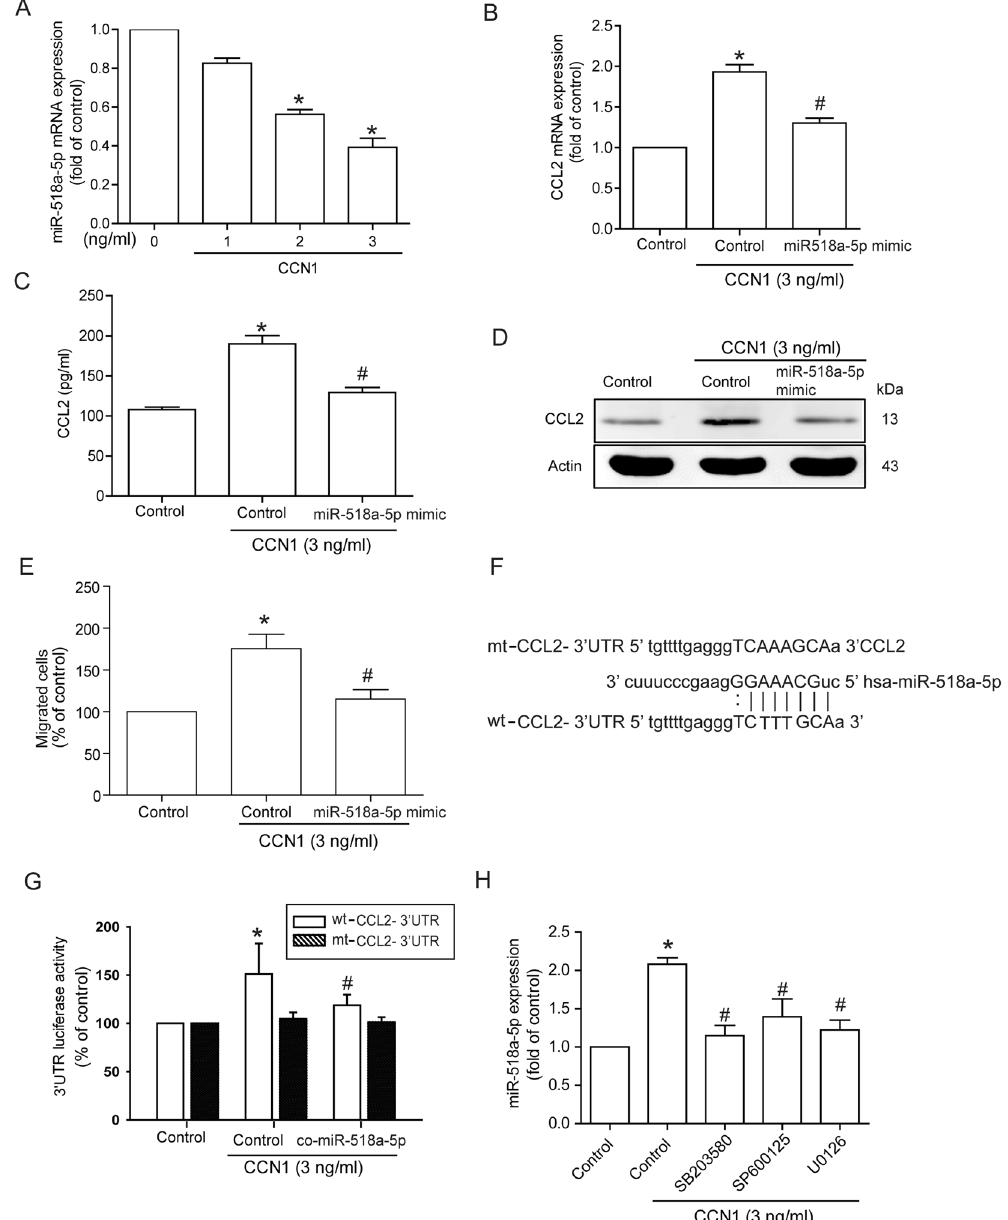
Figure 4. CCN1 promotes CCL2 expression and monocyte migration via inhibition of miR-518a-5p. ( A ) MG63 cells were incubated with CCN1 (1–3 ng/ml) for 24 h; miR-518a-5p expression was examined by qPCR (n = 5 per group). ( B – D ) MG63 cells were transfected with control miRNA or miR-518a-5p mimic for 24 h followed by stimulation with CCN1 for 24 h, and CCL2 expression was examined by qPCR, ELISA and Western blot analysis (n = 5 per group). ( E ) Medium was collected as CM and THP-1 migration was assessed by in vitro chemotaxis assay (n = 5 per group). ( F ) Schematic 3 ′ UTR representation of the human CCL2 containing the miR-518a-5p binding site. ( G ) MG63 cells were transfected with wt-CCL2-3 ′ UTR or mt-CCL2-3 ′ UTR plasmid for 24 h and stimulated with CCN1 for 24 h; relative luciferase/renilla activities were measured as described in the Methods section (n = 4 per group). ( H ) MG63 cells were pretreated with SB203580, SP600125, and U0126 for 30 min followed by stimulation with CCN1 for 24 h, and miR-518a-5p expression was examined by qPCR (n = 5 per group). Results are expressed as the mean ± S.E. * p < 0.05 compared with controls. # p < 0.05 compared with CCN1-treated